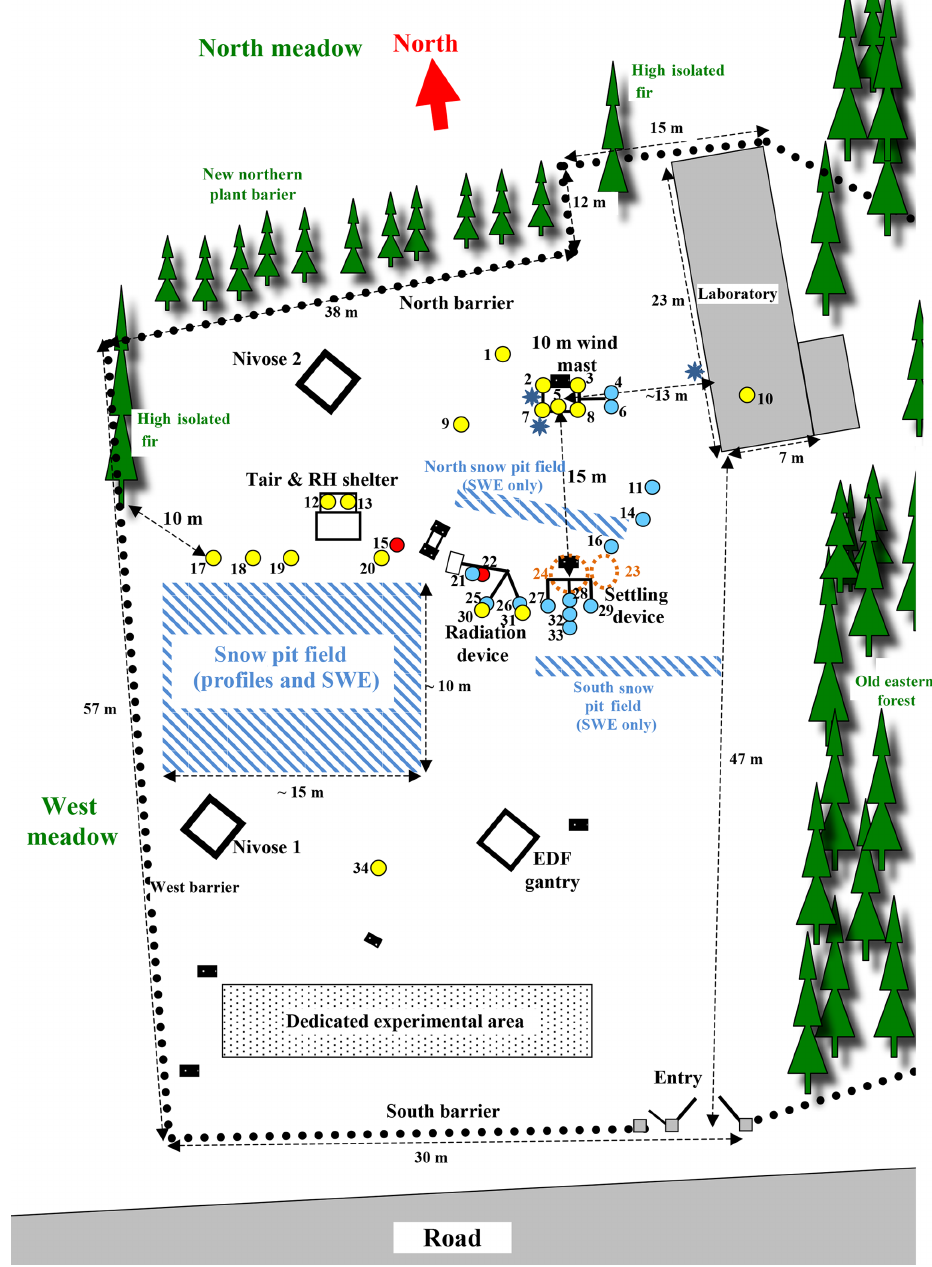
Figure 2. Schematic view of the experimental sites with sensor locations. The sensors indicated in yellow are for meteorological variables. The sensors indicated in red are not used anymore as of 2018, and those in blue correspond to snow measurements. Areas 23 and 24 correspond to soil temperature and humidity measurements. The correspondence between numbering and sensors is indicated in Tables 2, 3, and 4. The three dark blue asterisks correspond to the three hemispherical webcam locations. The dedicated experimental area has been used for specific experiments, e.g. Dumont et al. (2017) and Bouilloud and Martin